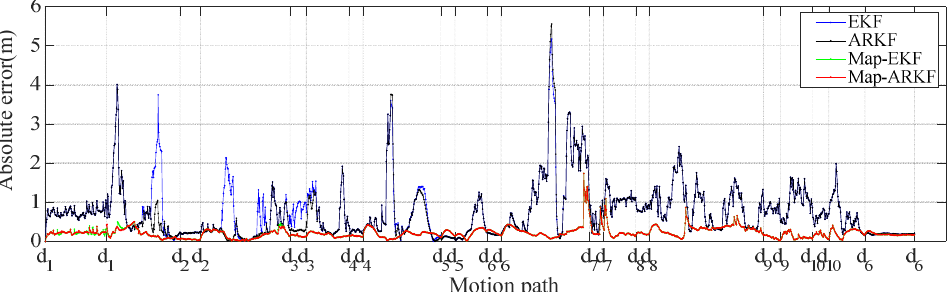
Figure 15. Absolute error of the algorithm.